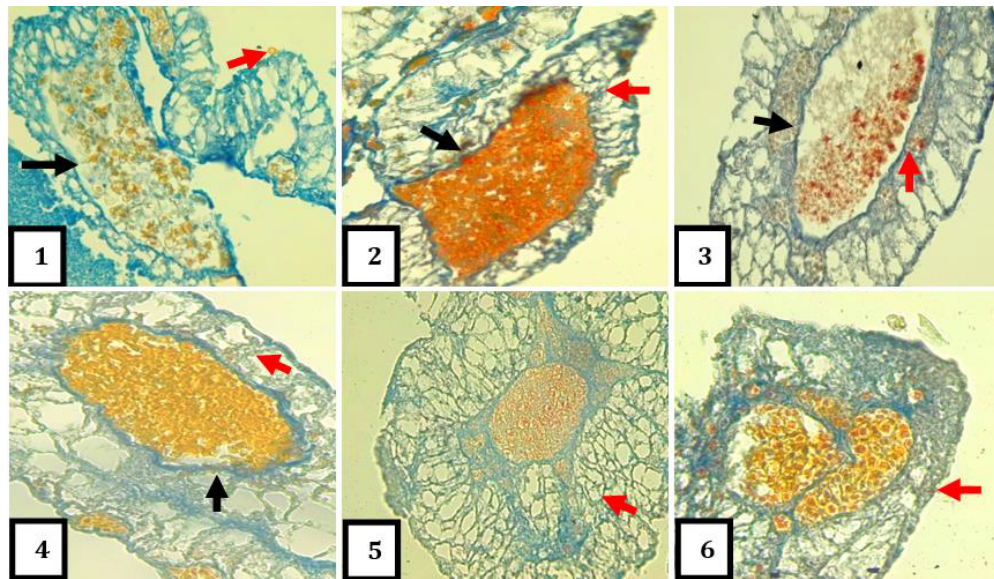
Figure 5. Histological images of CAM and blood vessels with MAF. 1: bFGF, 2: Thylophorine, 3: Extract 13.00 mg/mL, 4: Extract 9.75 mg/mL, 5: Extract 6.50 mg/mL, 6: Extract 3.25 mg/mL,black arrows: main blood vessel, red arrows: new blood vessel, magnification: